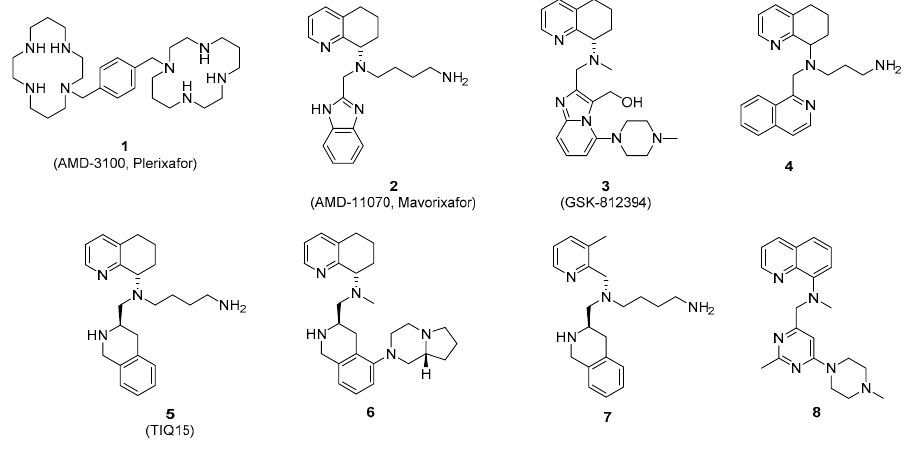
Figure 1. Small molecule CXCR4 antagonists.